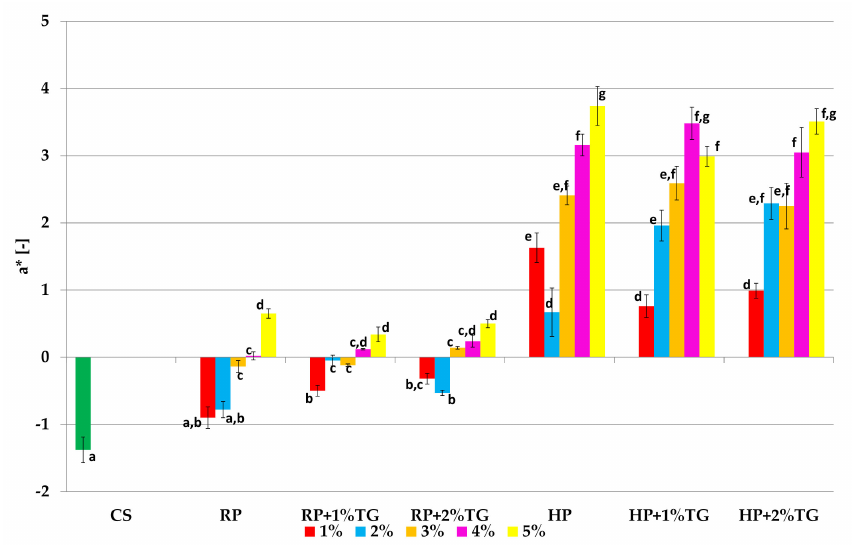
Figure 4. Average values of the a* parameter of instant noodles with the addition of rice protein, hemp protein and TGase (CS—control sample, RP—rice protein, RP+1%TG—rice protein with 1% TGase, RP+2%TG—rice protein with 2% TGase, HP—hemp protein, HP+1%TG—hemp protein with 1% TGase, HP+2%TG—hemp protein with 2% TGase). Columns correspond to various additions of rice protein. Mean values denoted by different letters ( a – g ) represent statistically significant differences between variables ( p < 0.05).